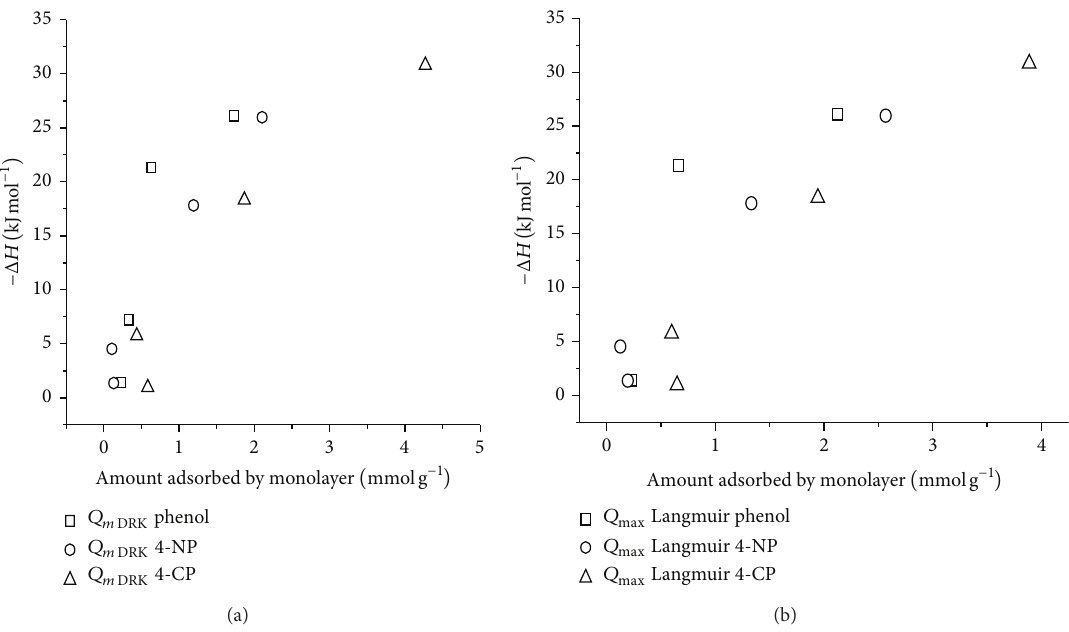
Figure 6: Correlation between the enthalpies changes of adsorption and amount adsorbed by monolayer of phenolson ACs.